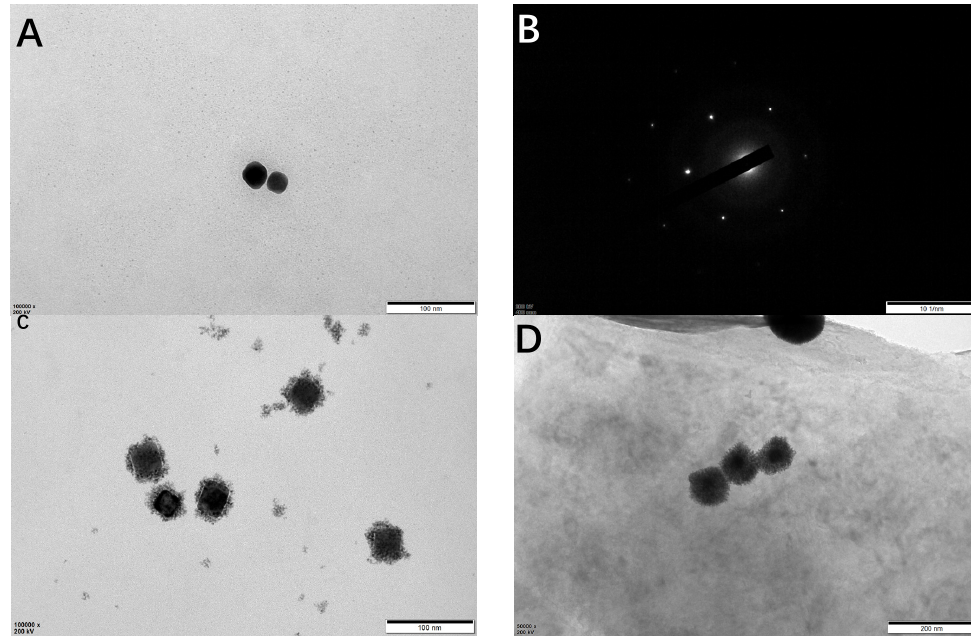
Figure 3. TEM images of cubic Au ( A ), diffraction pattern of cubic Au ( B ), Au@Pt DNs ( C ), and Au/Pt DNs-Ti 3 C 2 MXene ( D ).